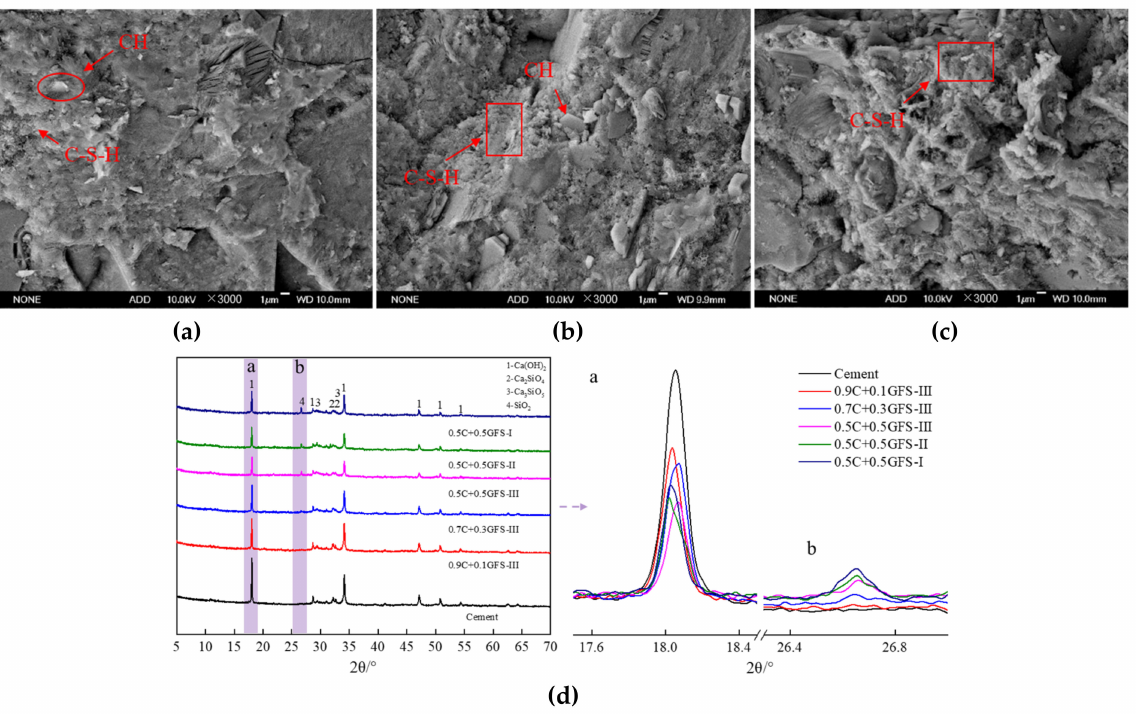
Figure 14. Microstructures and compositions of the hydrated products of GFS-blended cement pastes after their hardening for 90 d. ( a ) Cement, ( b ) 0.9Cement+0.1GFS-III, ( c ) 0.5Cement+0.5GFS-III, ( d ) XRD patterns of the blended cement hardened over 90